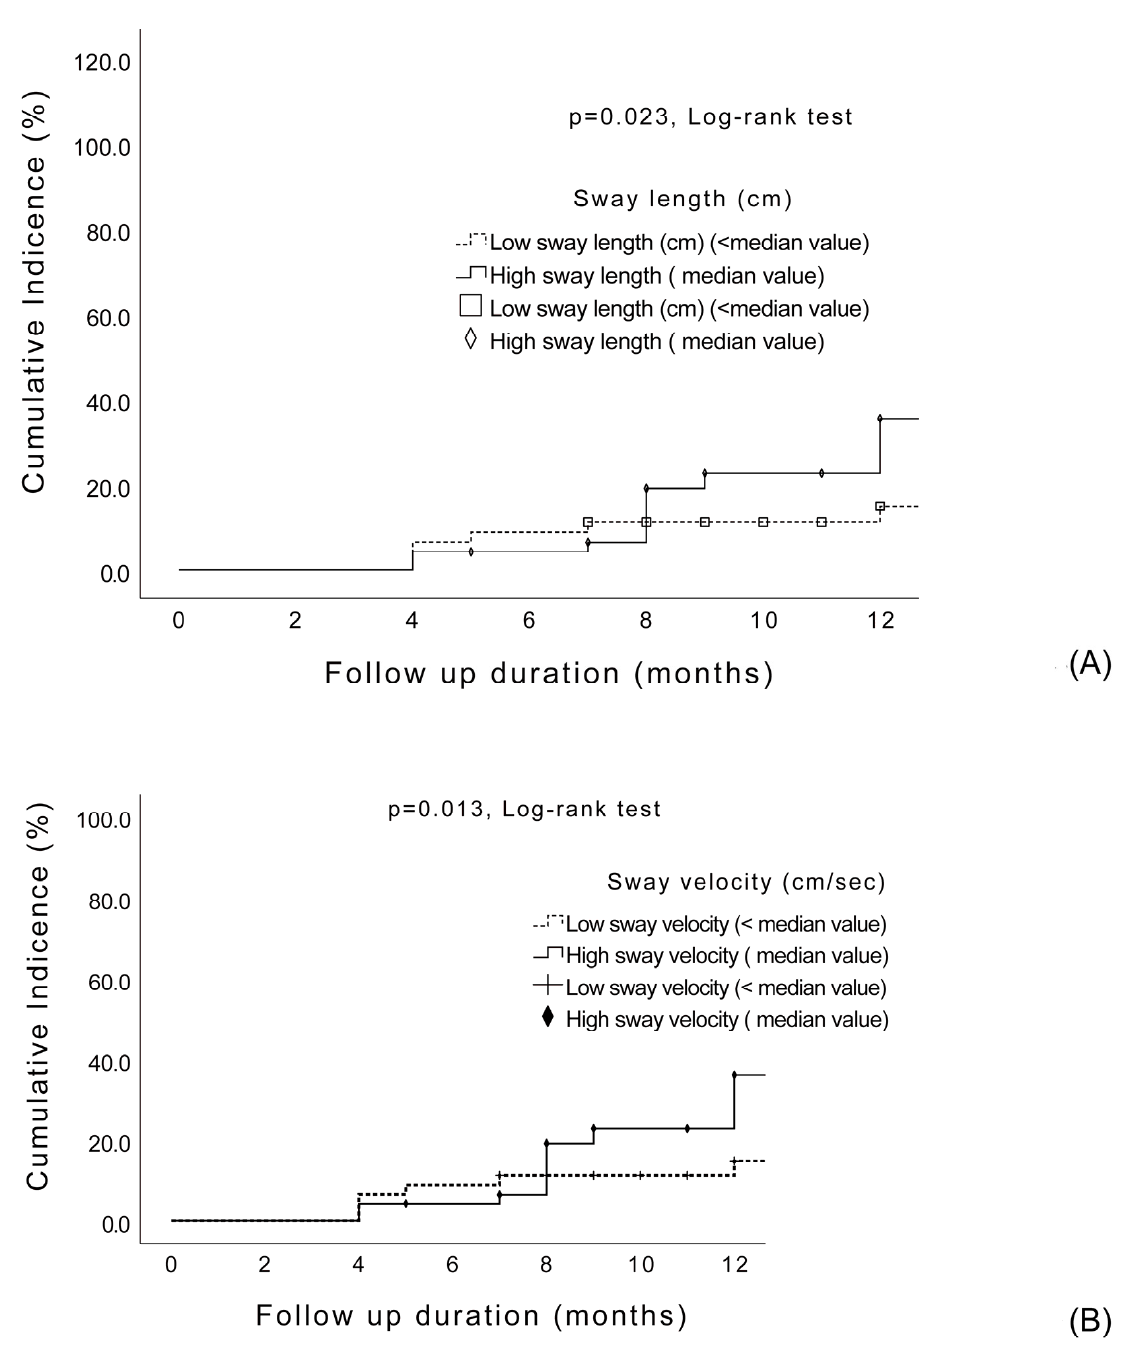
Figure 3. The cumulative risk of sway length ( A ) and velocity ( B ) for the development of future falls in patients with PD. Table 3. Risk factors of clinical scores and posture sway parameters associated with prospective falls in Cox’s proportional hazards model.